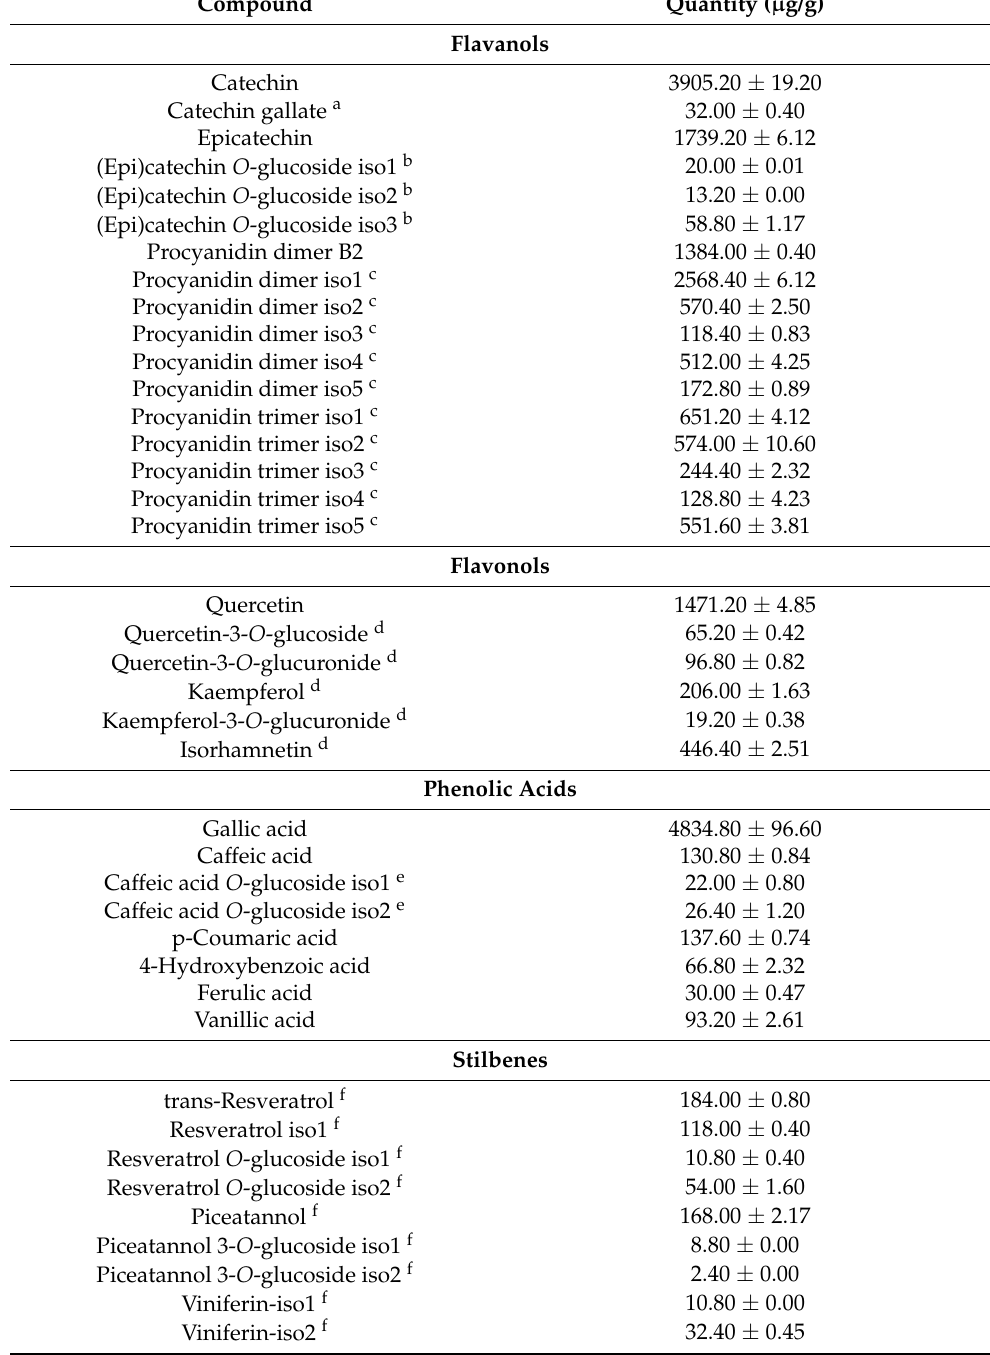
Table 2. Non-anthocyanin compounds found in wine lees powder by